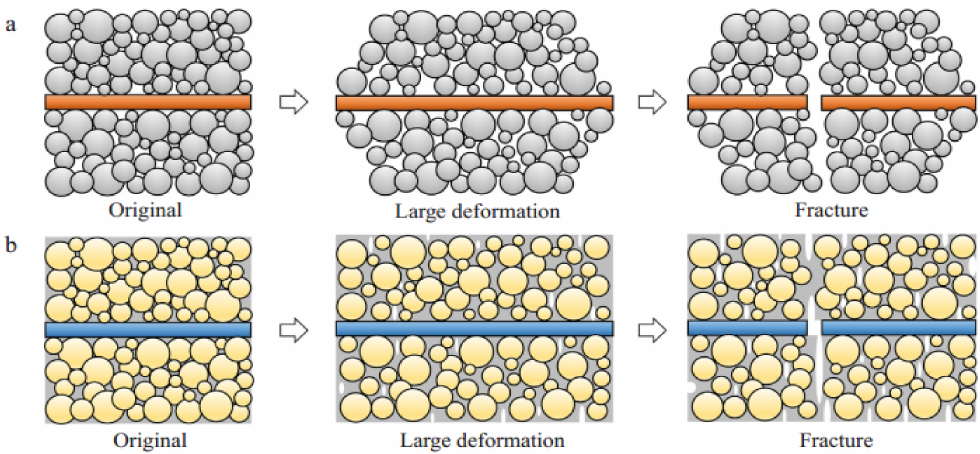
Figure 8. Schematics illustrating the deformation and fracture process of an ( a ) anode and ( b ) cathode